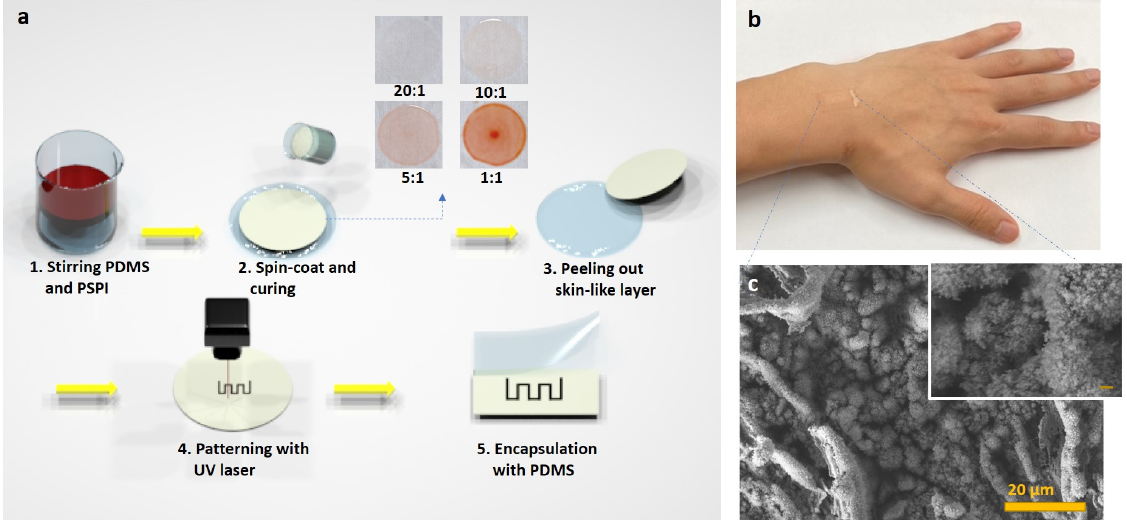
Figure 1. E-skin formed from skin-like polymer using UV pulsed laser irradiation; ( a ) schematic of fabrication process of e-skin from skin-like polymer, ( b ) E-skin placed onto wrist to sense joint movement, ( c ) SEM image of laser induced graphene (LIG) patterned on skin-like polymer. (scale bar: 20 μ m).